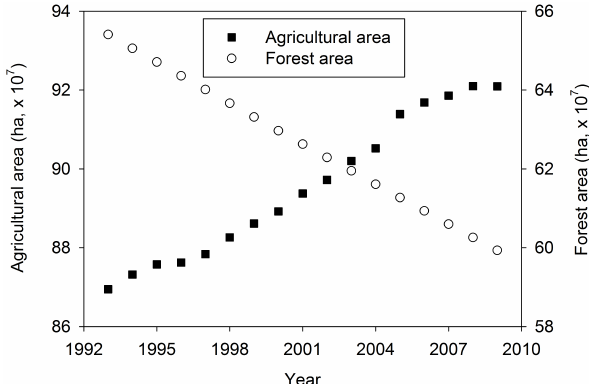
Figure 1. Change in areas of agricultural land and forest in Africa. Data source: FAOSTAT, http://faostat.fao.org/site/377/